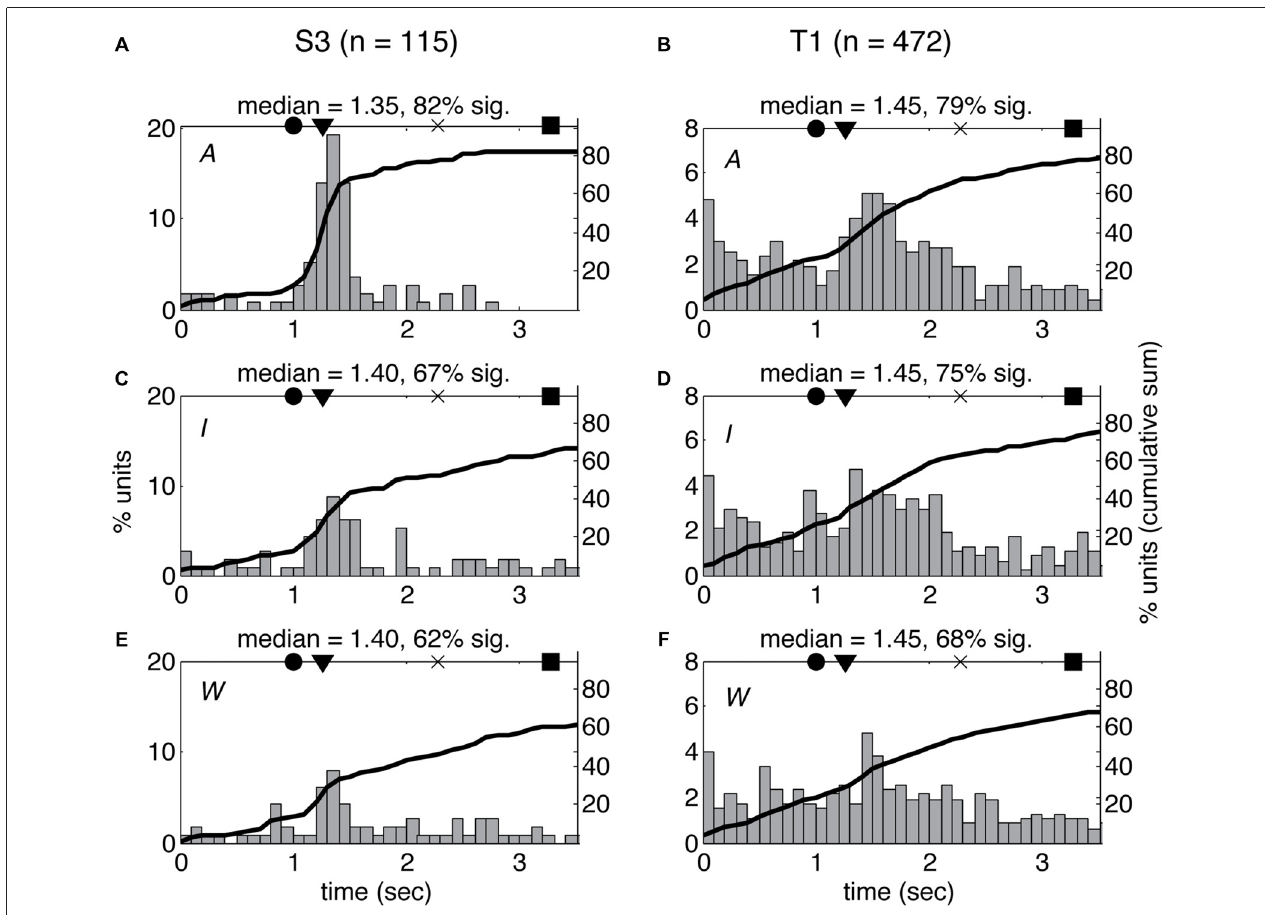
FIGURE 5 | Latency of neural response does not vary across volitional states. Histogram of single-unit response latencies (occurrence of first significant change in firing rate, see “Materials and Methods” section) for both participants (S3: A , C , E ; T1: B , D , F ) across the three VoS conditions (attempt: A , B ; imagine: C , D ; watch: E , F ). Time zero corresponds to the beginning of the movies. Circles denote the time of target illumination, triangles movement onset, × maximum velocity and squares target acquisition. Black line shows the cumulative sum of the percentage of neurons displaying significant changes in firing rate at each time point.